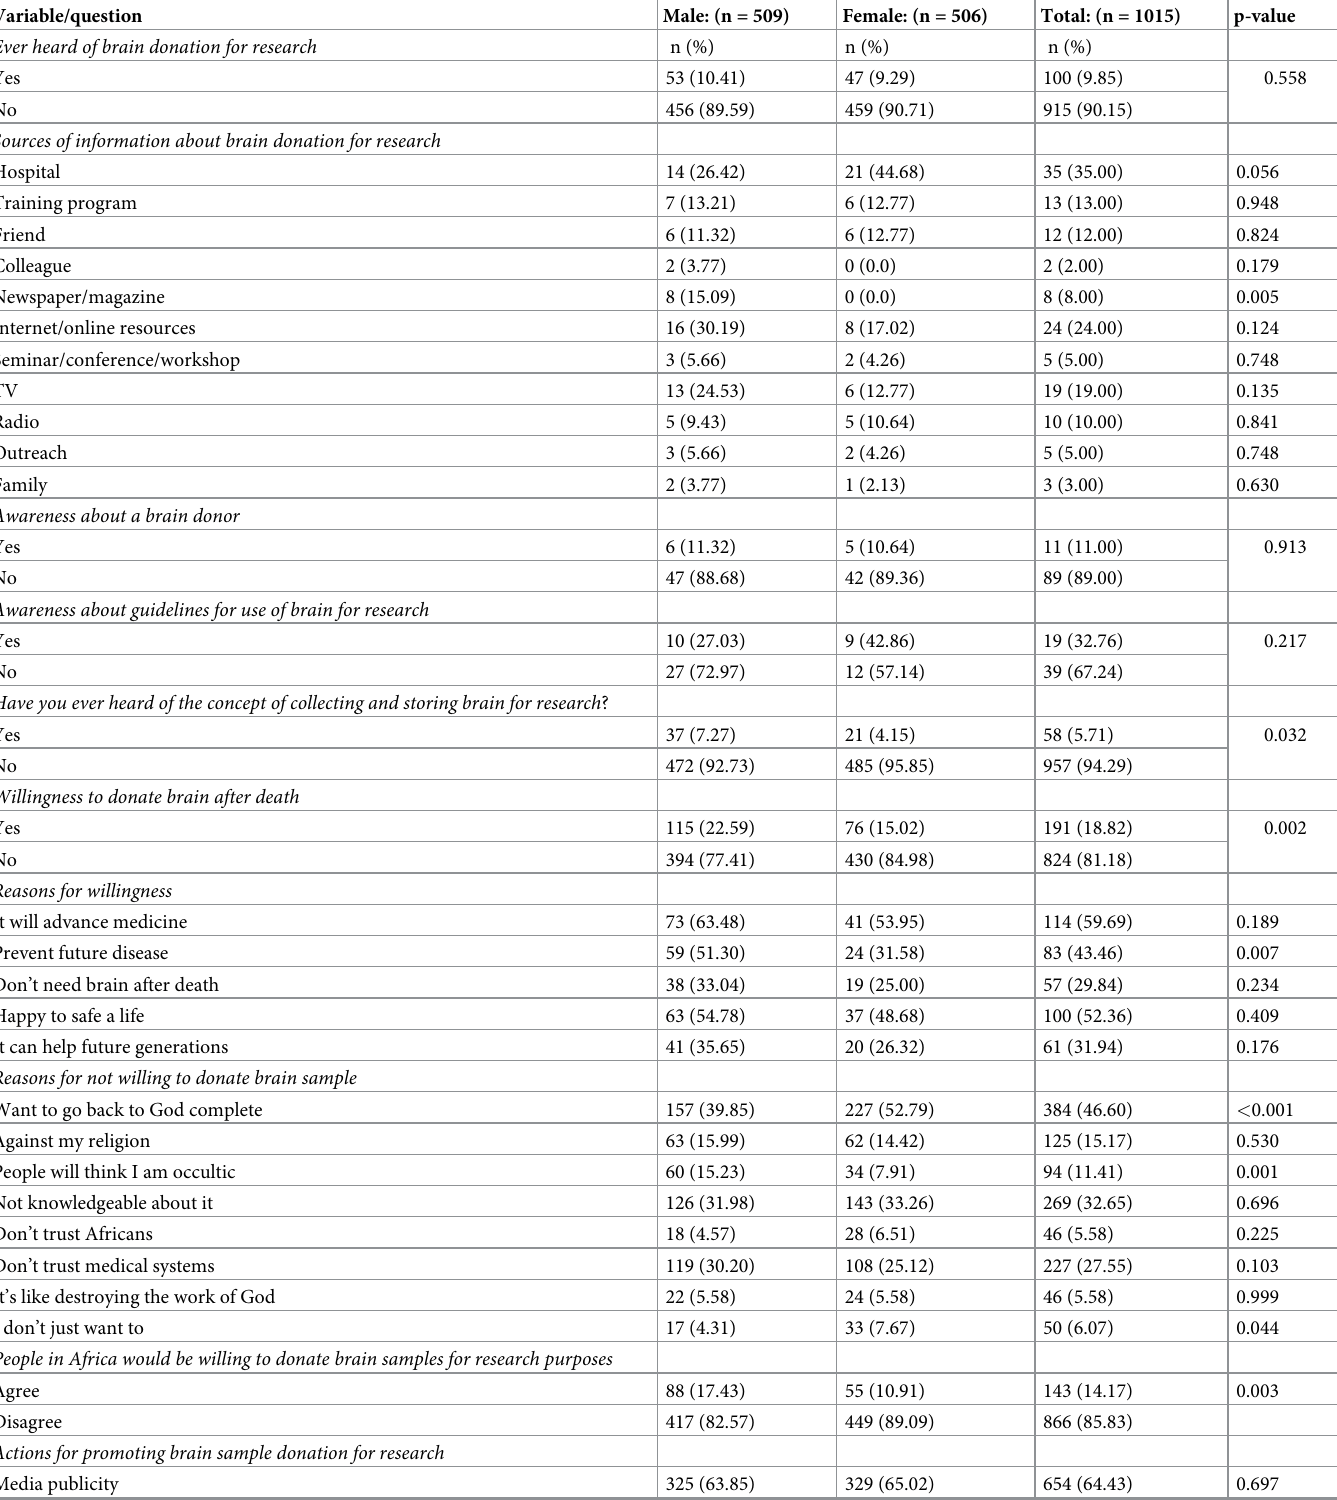
Table 3. Awareness and knowledge related to brain donation.